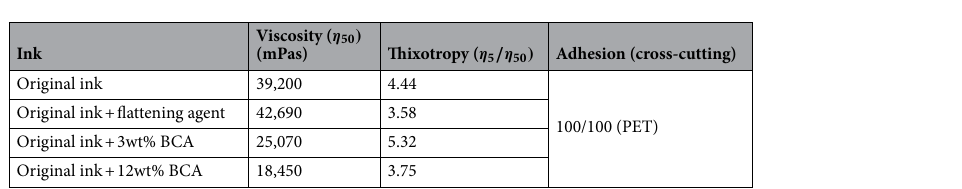
Figure 9. Implemented IoT devices. ( A ) The structure of the implemented IoT devices, and ( B ) Testing the implemented IoT devices.